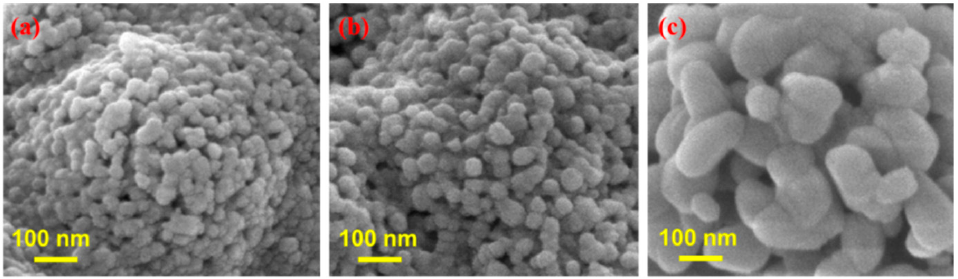
Figure 4. SEM images of the ZnO nanoparticles synthesized at a constant applied potential of 16 kV; a distance between collector and nozzle of 12 cm; a flow rate of 1 mL/h; and calcination temperature of ( a ) 600 °C, ( b ) 700 °C, and ( c ) 800 °C.